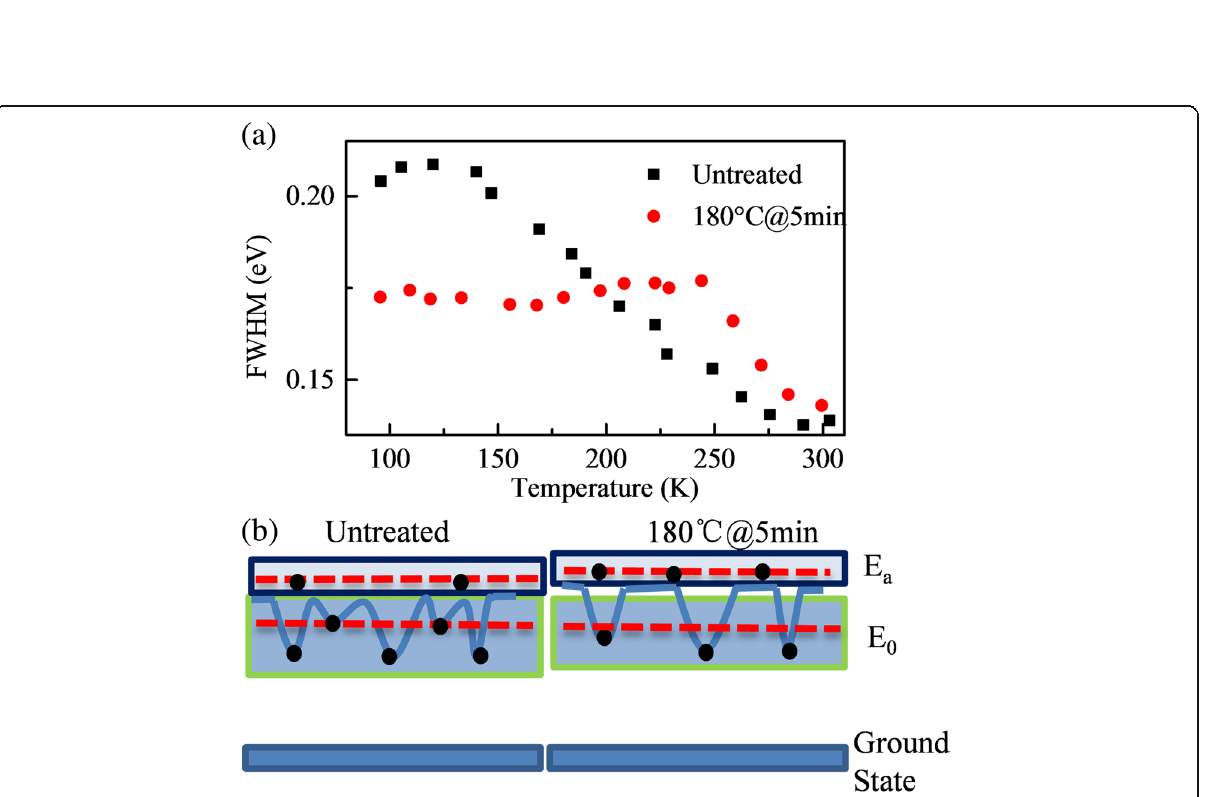
Fig. 6 a The FWHM changes with temperature of peak A for the untreated sample and sample annealed at 180 °C for 5 min, respectively. b The change of energy band by annealing on QD